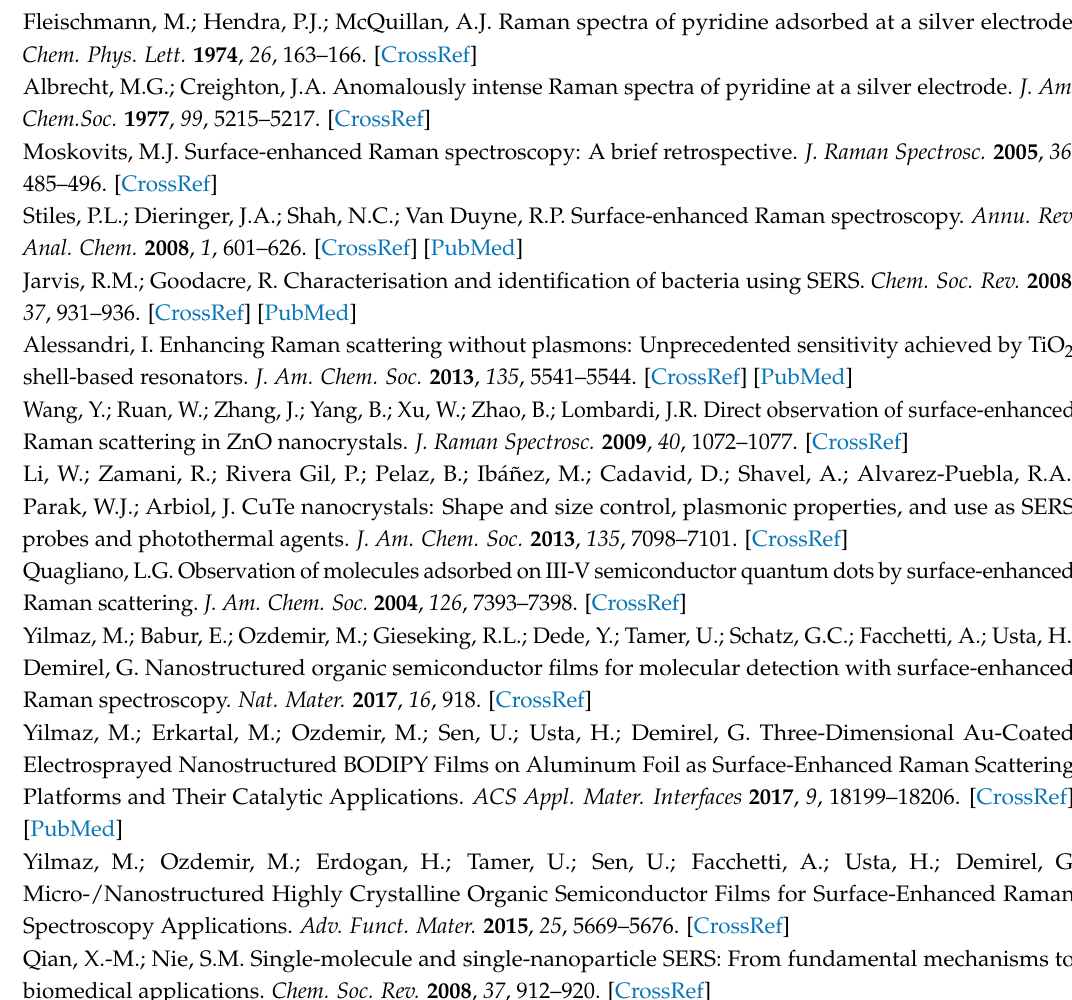
Figure S1: Variations of the ellipsometric parameters (a) Ψ , (b) ∆ , (c) imaginary ( ε i ), and (d) real ( ε r ) parts of the dielectric functions for the unidirectional GNAs depending on the direction of incoming light; Figure S2: Representative SEM images of GNA@PDOP films for different dopamine polymerization times at different magnifications. (a,b) 10 min, (c,d) 60 min, and (e,f) 180 min; Figure S3: EDX elemental mapping of GNA@PDOP@AgNP SERS platform. PDOP deposition time is 30 min; Figure S4: Representative SEM images